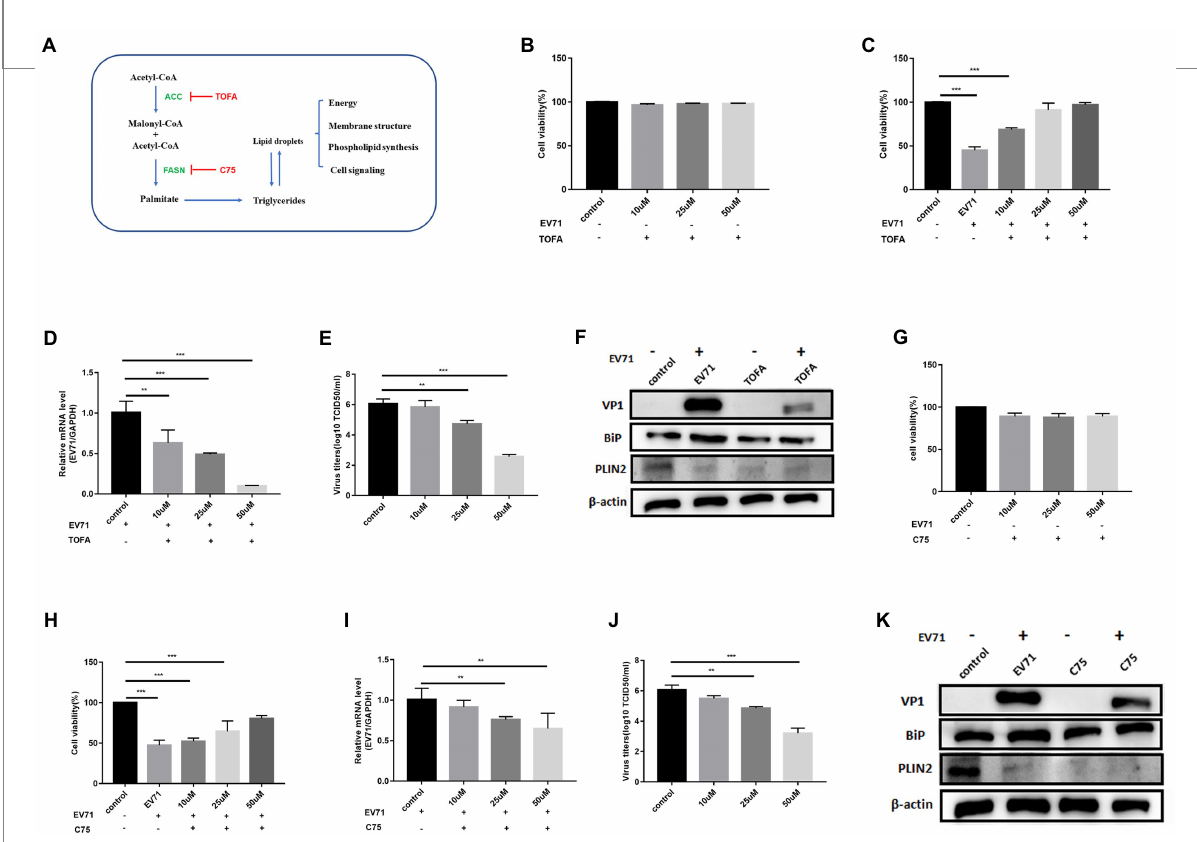
FIGURE 3 Both TOFA and C75 inhibit EV-A71 replication. (A) The de novo fatty acid biosynthetic pathway and the biological functions of lipid. Key enzymes in the pathway are highlighted acetyl-CoA carboxylase (ACC) and fatty acid synthase (FASN) as well as their cognate inhibitors TOFA and C75, respectively. (B) 10 μ M, 25 μ M and 50 μ M TOFA were used to treat cells for 12 h. cell viability was detected by CCK8. (C)–(E) HUVECs were treated with 10 μ M, 25 μ M, and 50 μ M TOFA for 12 h and then incubated with EV-A71 for 12 h. (C) Cell viability was detected with CCK8. (D) Total intracellular RNA was extracted and then EV-A71 gene expression levels were detected by RT-qPCR. (E) The culture supernatants were collected to detect virus titer. The virus titers of 10 μ M, 25 μ M, and 50 μ M TOFA were 5.88 × 10 5 TCID50/ml, 5.12 × 10 4 TCID50/ml, 3.63 × 10 2 TCID50/ml, respectively. (F) Detection of VP1, BiP and PLIN2 protein expression levels. Blank (1st channel), be infected with EV-A71 for 12 h (2nd channel), 50 μ M TOFA treated HUVECs for 12 h (3rd channel), and 50 μ M TOFA pretreated HUVECs for 12 h and then co-incubated with EV-A71 for 12 h (4th